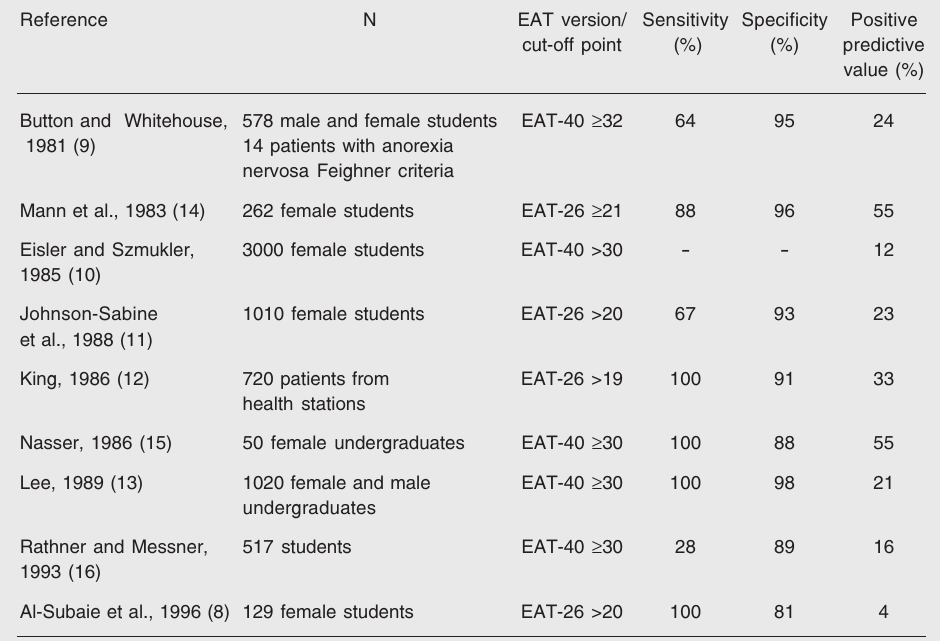
Table 1. The validity coefficients of the Eating Attitudes Test